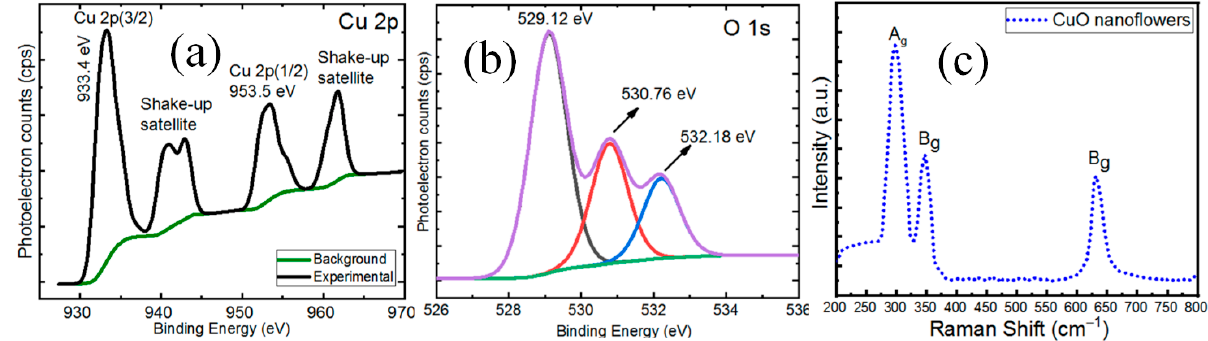
Figure 3. ( a , b ) XPS high-resolution (core level) or narrow energy range spectra of Cu 2p and O 1s, respectively, from as-synthesized CuO nanoflowers, respectively; ( c ) Raman analysis of CuO nanoflowers sample.